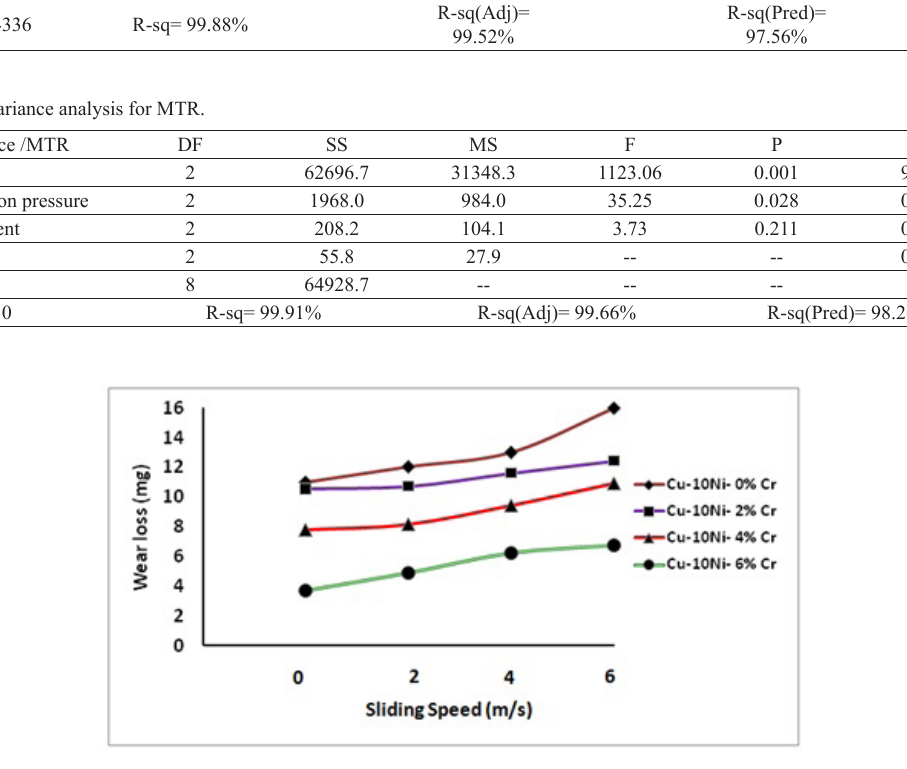
Figure 4. Wear behaviors of